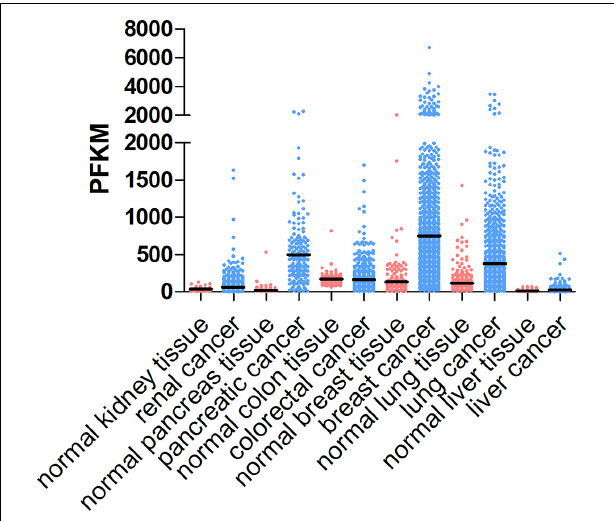
FIGURE 1 | COL1A1 expression levels in different cancer types and corresponding normal tissues. COL1A1 expression levels vary in different types of cancer, including renal cancer, pancreatic cancer, colorectal cancer, breast cancer, lung cancer, and liver cancer and generally are higher in tumor tissues than those in normal tissue. The data are obtained from https://www.proteinatlas.org/ENSG00000108821-COL1A1/tissue and